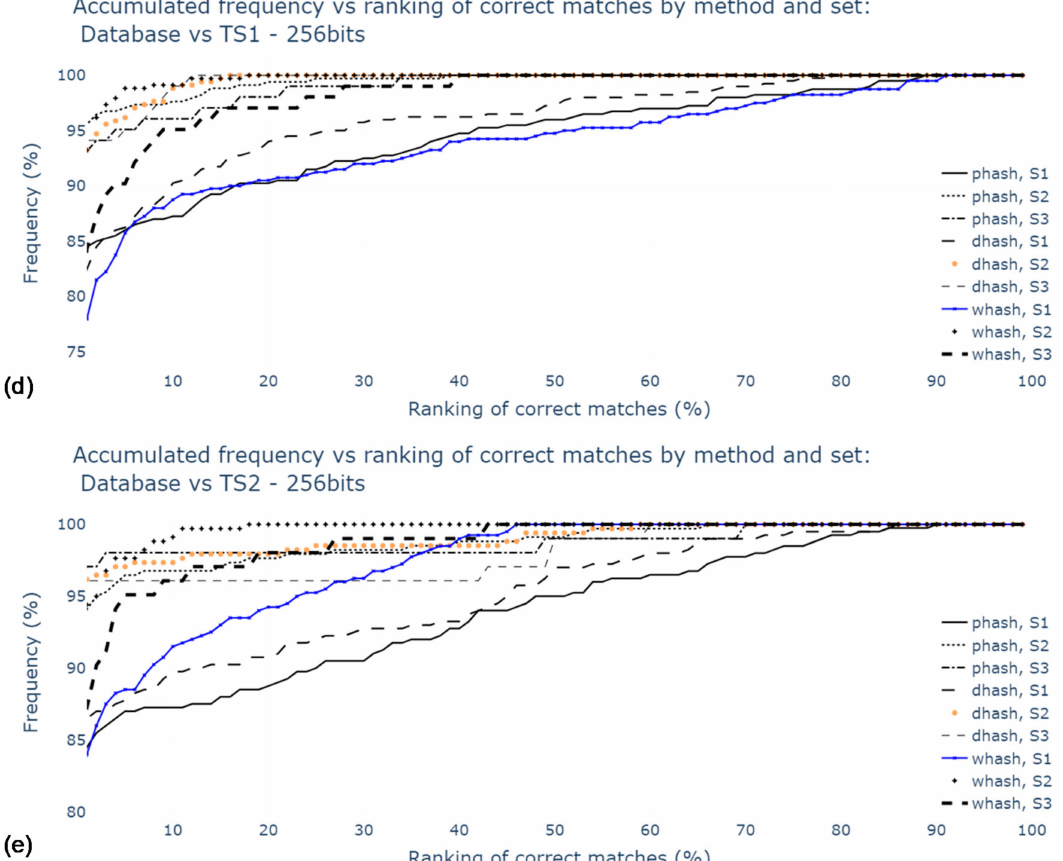
Figure 11. Percentage of correct matches with Radon transform and contrast stretching: for the worst cases between TS1 and TS2 comparisons and only for top 1, top 5, top 10: ( a ) using S1; ( b ) using S2; ( c ) using S3; ( d ) for the comparison with TS1, all rankings (in percentage); ( e ) for the comparison with TS2, all rankings (in